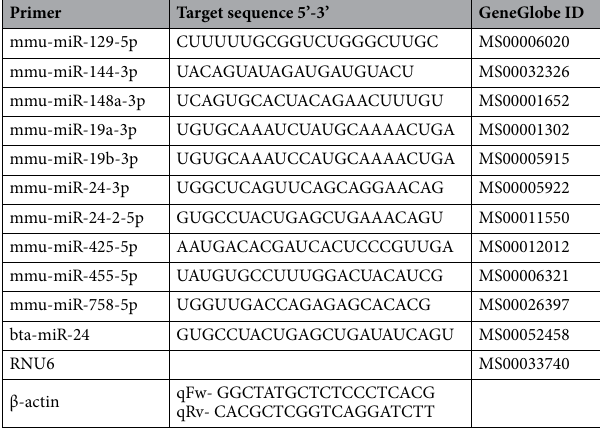
Table 4. List of primers used in this